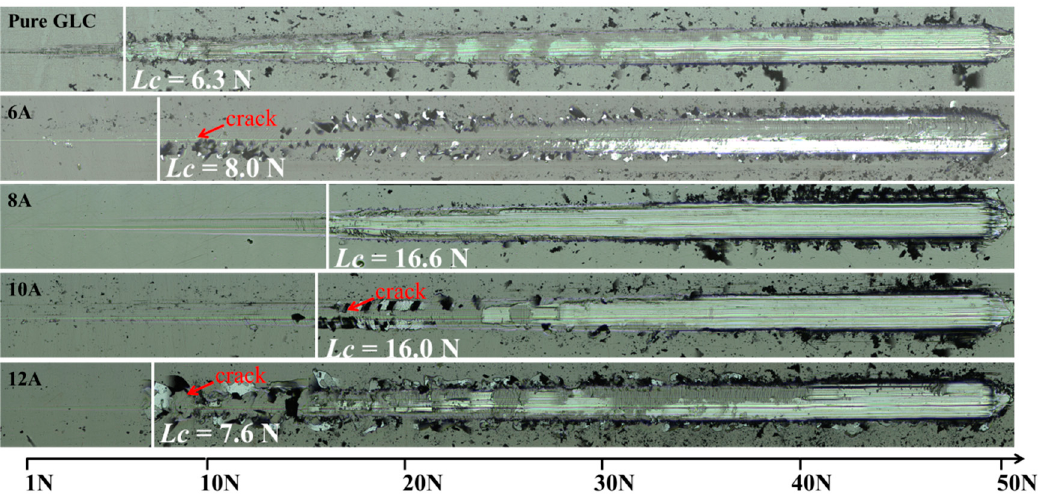
Figure 9. Scratch tracks of the TiC/GLC multilayered films and pure GLC film.